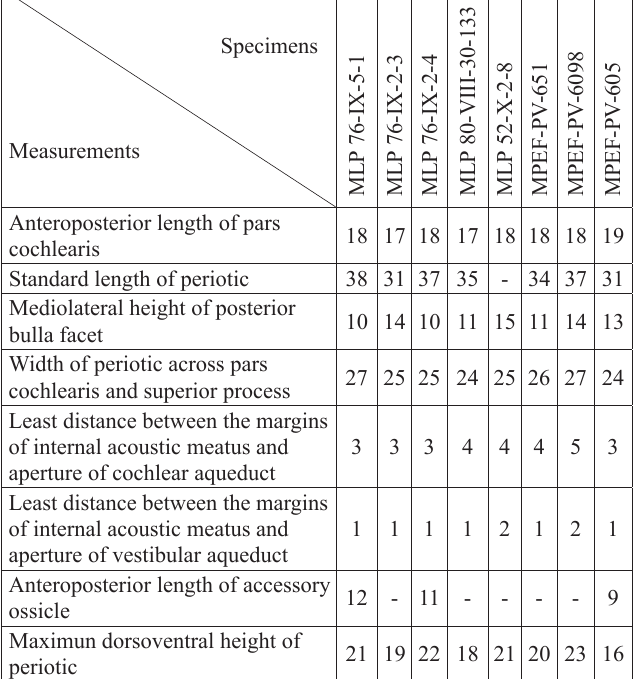
Table 1. Measurements (in mm) of the periotics of the Patagonian Mio- cene Physeteroidea indet. included in our